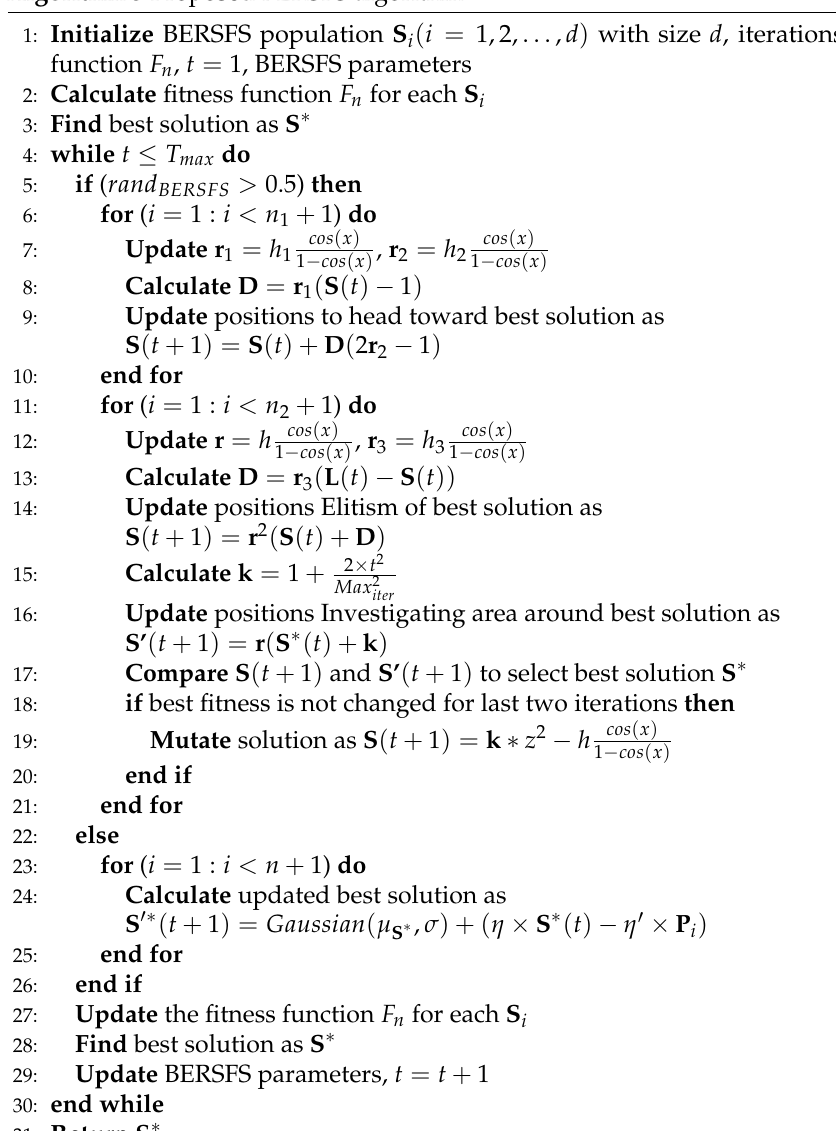
Algorithm 3 Proposed BERSFS